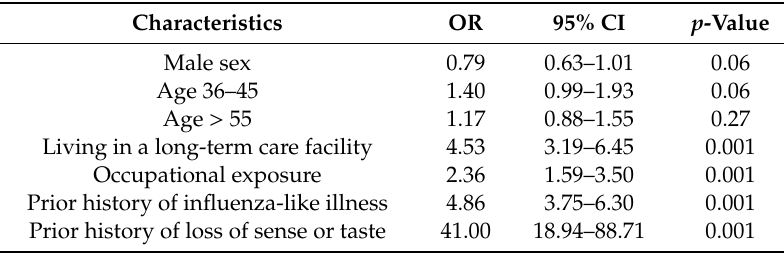
Table 4. Results of the generalized estimating equations model of risk factors associated with SARS-CoV-2